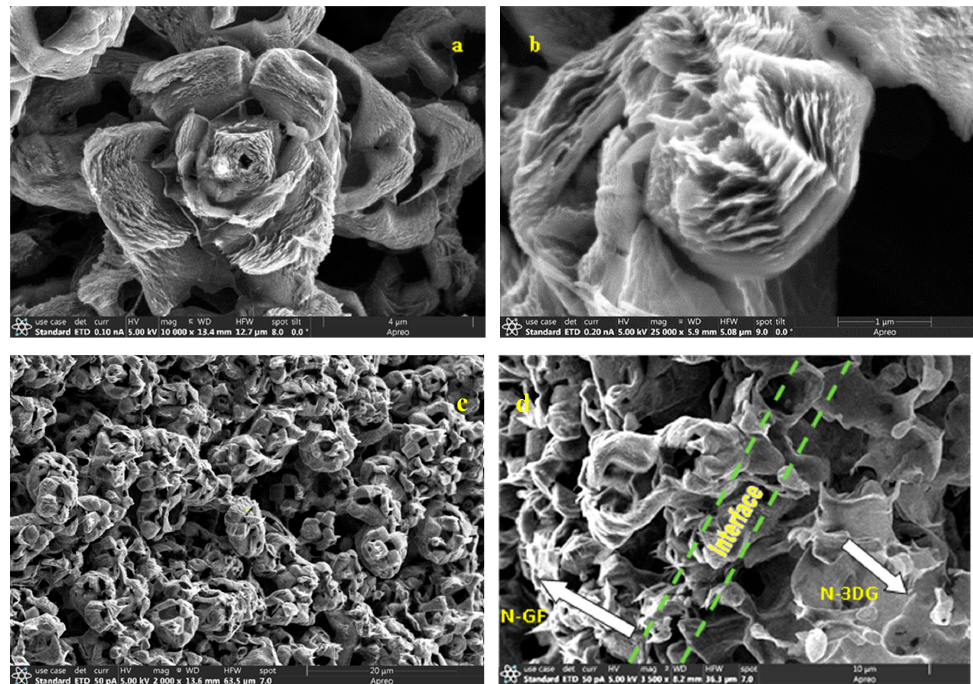
Figure 2. SEM images of N doped graphene flower ( a ) with 20% C 2 H 2 -sample H2, ( b ) with 5% C 2 H 2 -sample H3, ( c ) low magnification top view of sample H2 showing distribution of N-GF, ( d ) cross sectional image of H2 illustrating N-3DG, N-GF, and the interface between them.